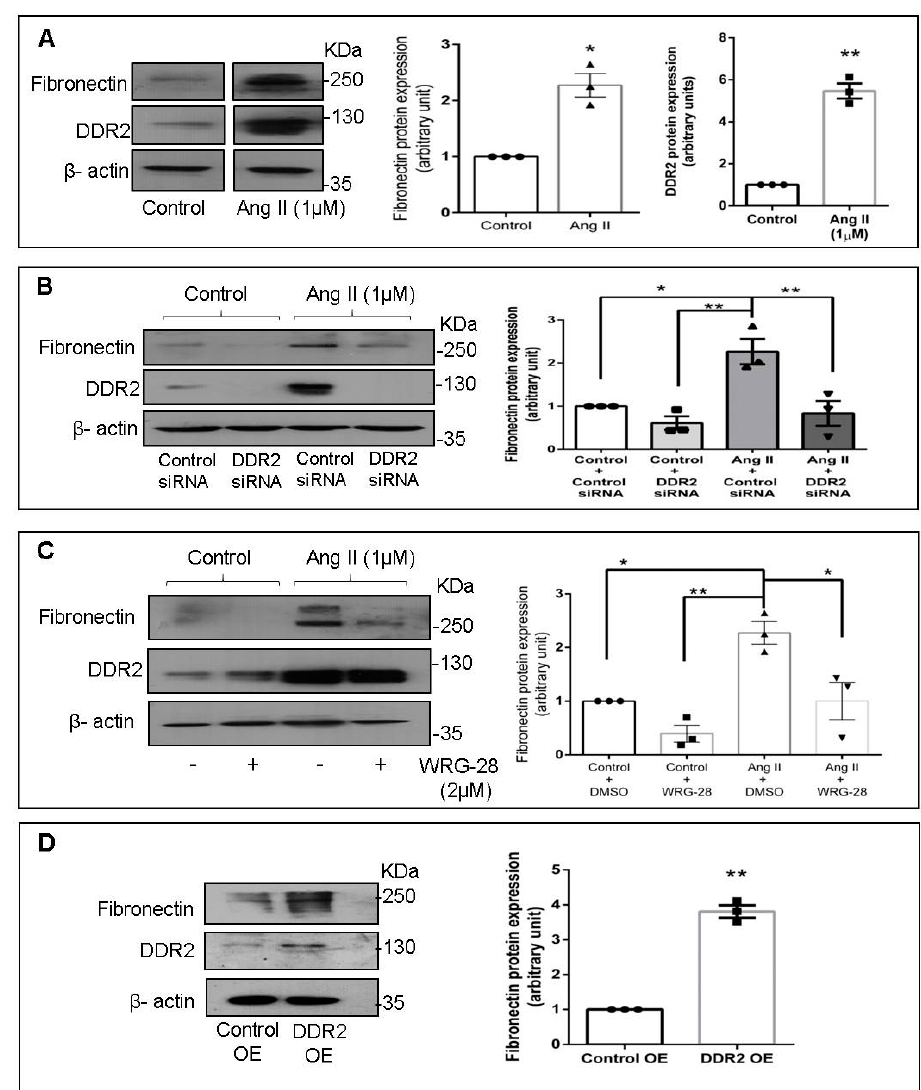
Figure 1. DDR2 mediates Ang II-stimulated fibronectin protein expression in cardiac fibroblasts. ( A ) Sub-confluent quiescent cultures of cardiac fibroblasts were stimulated with Angiotensin II (Ang II) (1 µM). Protein was isolated at 12 h of Ang II treatment and subjected to Western blot